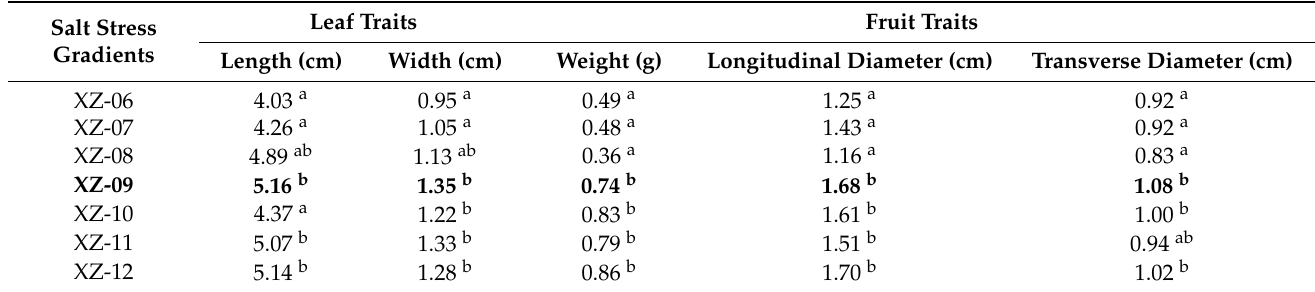
Table 2. Effect of various salinity gradients on key wolfberry leaf and fruit traits.